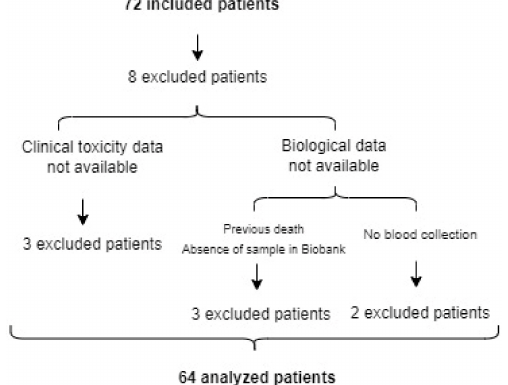
Figure 1. Patients’ inclusion diagram. Patients recruited and those finally included in the study after applying exclusion criteria such as the absence of clinical data or biological data (a blood sample for